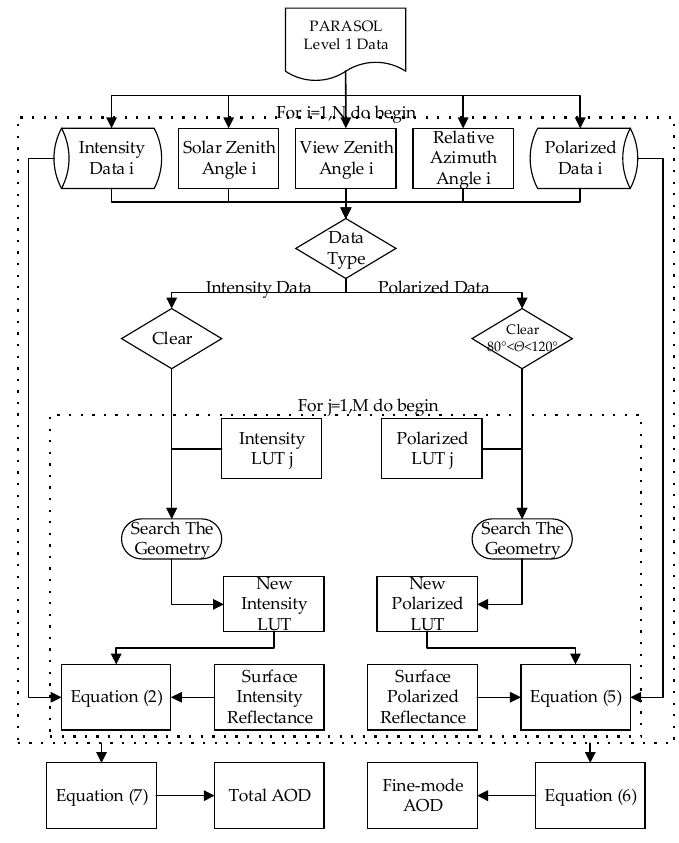
Figure 2. The total and fine-mode AOD retrieval flow chart.